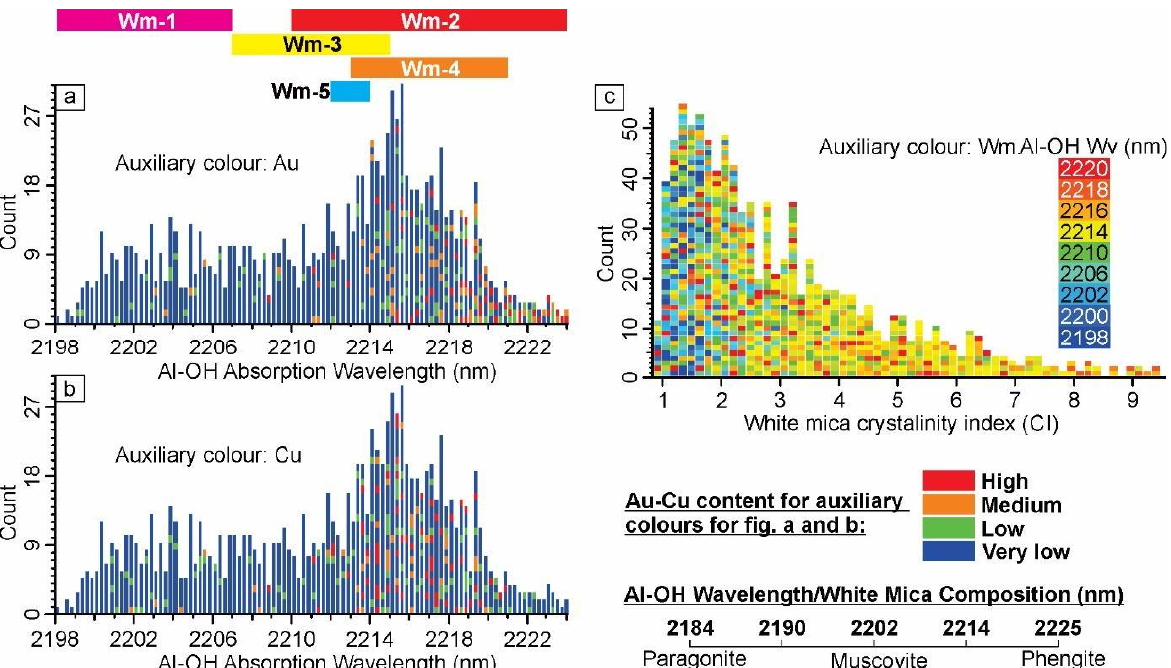
Figure 9. White mica spectral data and Au-Cu content integration from Paraíba samples. Histogram of Al-OH feature position for overall white mica samples related to Au content ( a ) and Cu content ( b ). The colored horizontal bars above the histograms indicate the interval of Al-OH absorption wavelengths associated with the white mica groups (Wm – 1 to Wm – 5). ( c ) Histogram of white mica crystallinity index (CI), with white mica Al-OH wavelength (Al-OH Wv) in auxiliary colors. The maximum CI value of Paraíba samples is 15, but there are few samples with CI above 9. This is considered as the maximum value in this figure for clarity.